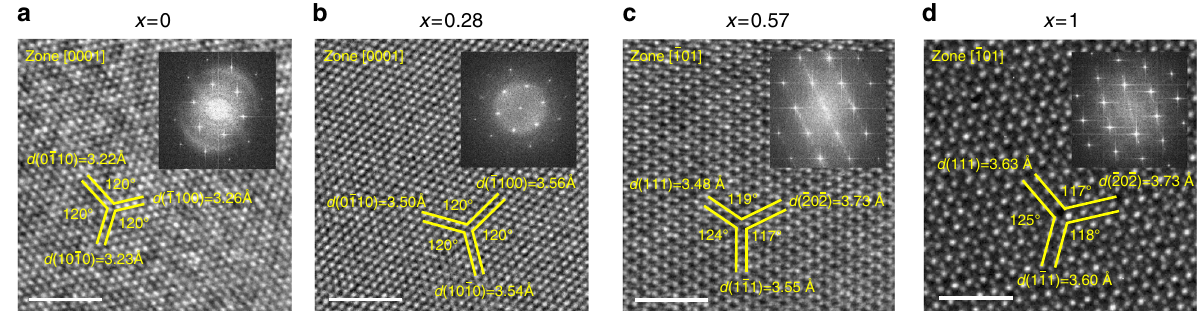
Fig. 5 Evidence of phase transition from TEM. TEM and FFT patterns for GaSe 1 − x Te x with a x = 0, b 0.28, c 0.57, and d x = 1. The zone axis, interplanar distance, and angle between planes are indicated in each image. Scale bars = 2